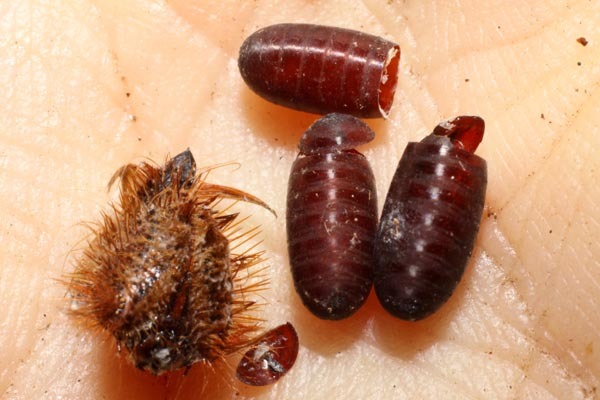
Puparia of Hyphantrophaga
morphophaga voucher n. DHJPAR0016681, reared from Morpho
helenor voucher n. 06-SRNP-36610. Image voucher n. DHJ469258.jpg